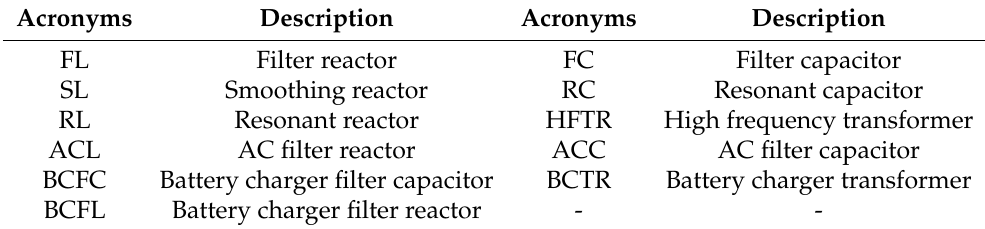
Figure 2. Structure of the propulsion control system for resonant auxiliary power supply. Table 1. Component abbreviation of the resonant auxiliary power supply.